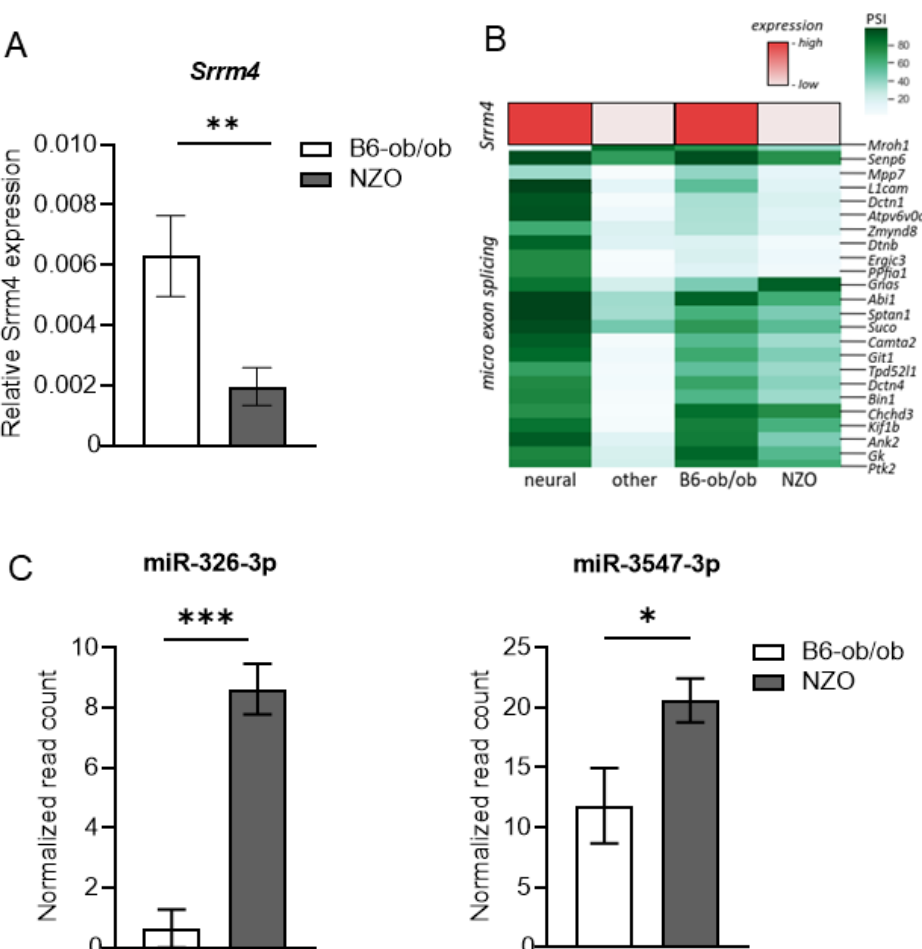
Figure 3. Dysregulated splicing of microexons. ( A ) Relative expression of Srrm4 in islets of male B6-ob/ob and NZO mice ( n = 4) analyzed by qRT-PCR. Data are shown as mean ± SD, Student’s t -test with Welch’s correction. ( B ) Relative expression of Srrm4 from our and published data [27]. RNAseq data shown in red. Analysis of genes containing spliced microexons as listed in [27] in different tissues and islets of Langerhans from B6-ob/ob and NZO male mice represented in green. PSI = percent spliced in. ( C ) Elevated expression of miR-326-3p and miR-3547-3p in islets of NZO. Data extracted from miRNA-seq data from [29].* p < 0.05; ** p < 0.01; *** p < 0.001.